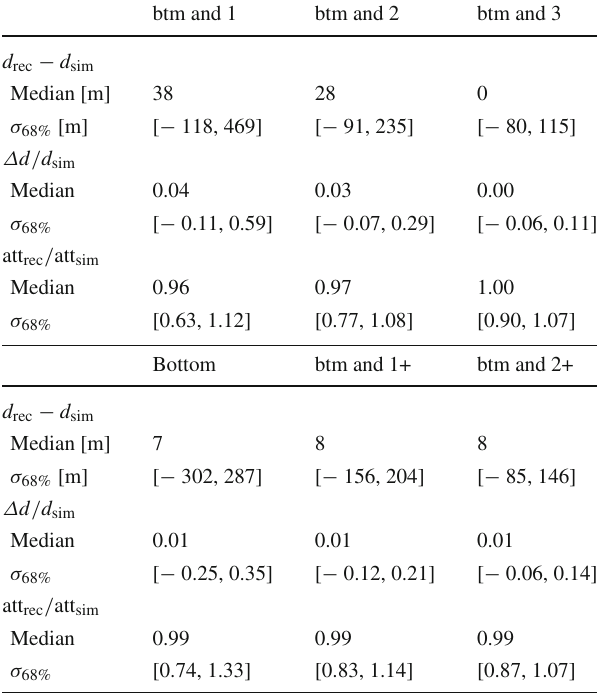
Table 2 Median and 68% quantiles of the absolute and relative uncer- tainties on the vertex distance, and the ratio between reconstructed and actual attenuation factor exp ( − d / l att )/ d . In the upper table, events are divided into categories where at least one of the channels at ∼ 100 m depth has detected a pulse with SNR ≥ 2 . 5, as well as exactly one, exactly two or exactly three of the upper channels on the power string. In the lower table, categories where at least one of the channels at ∼ 100 m depth has detected a signal and where at least one, two or three of the channels further up the power string detected a signal with SNR ≥ 2 .